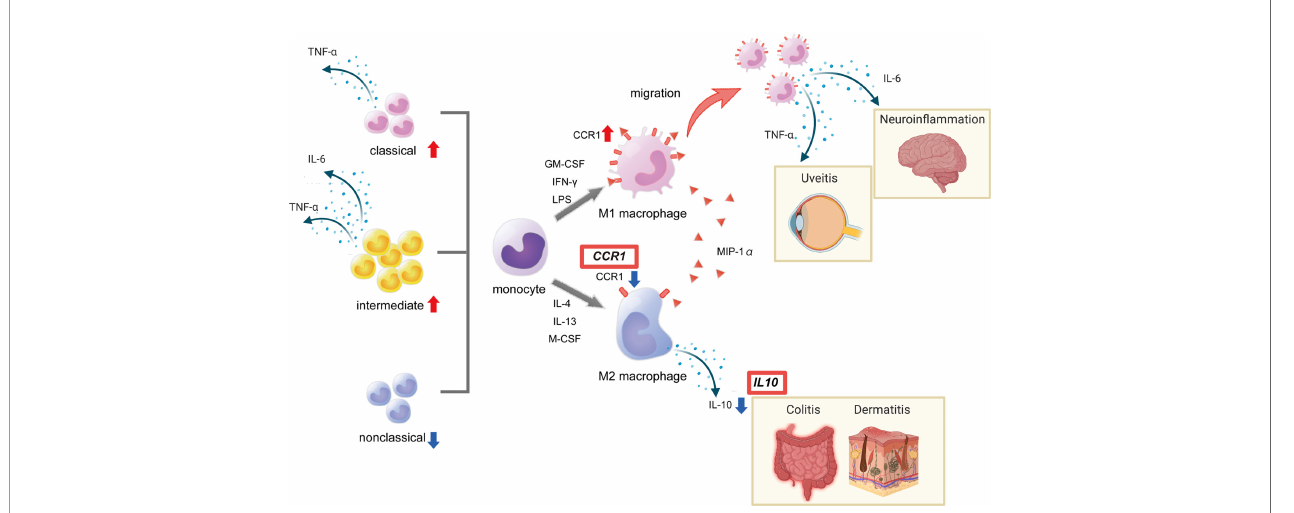
FIGURE 2 | Red boxes show disease susceptibility genes for BD associated with this pathway. This fi gure was created with